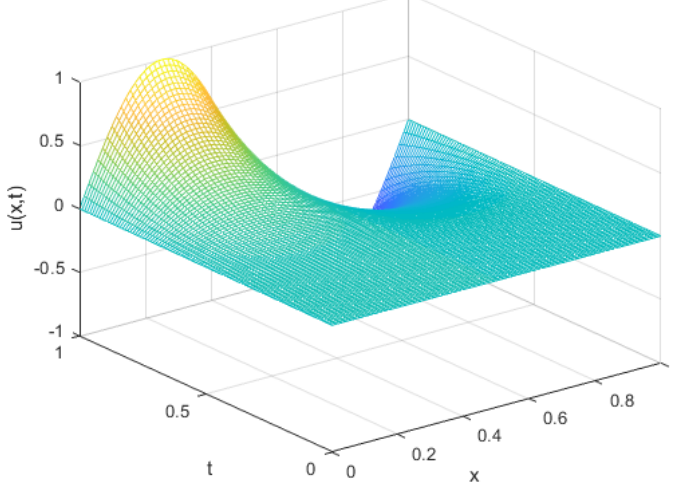
Figure 2. Exact solution surface for Example 1.